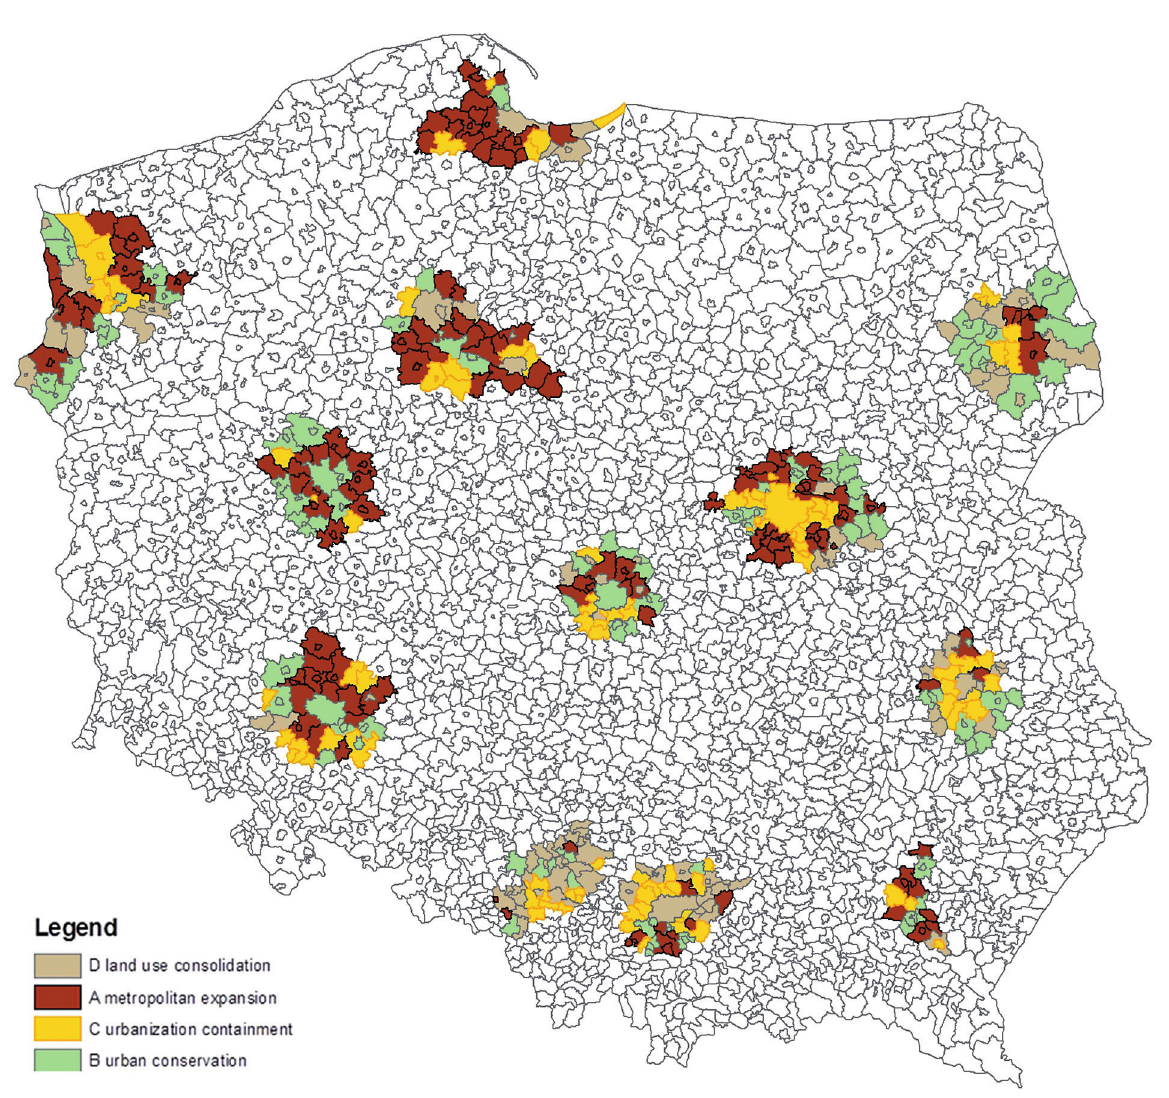
Fig. 8. Spatial interactions vs. land use changes in the metropolitan areas of Poland (quotients of population potentials vs. quotients of entropy indices),